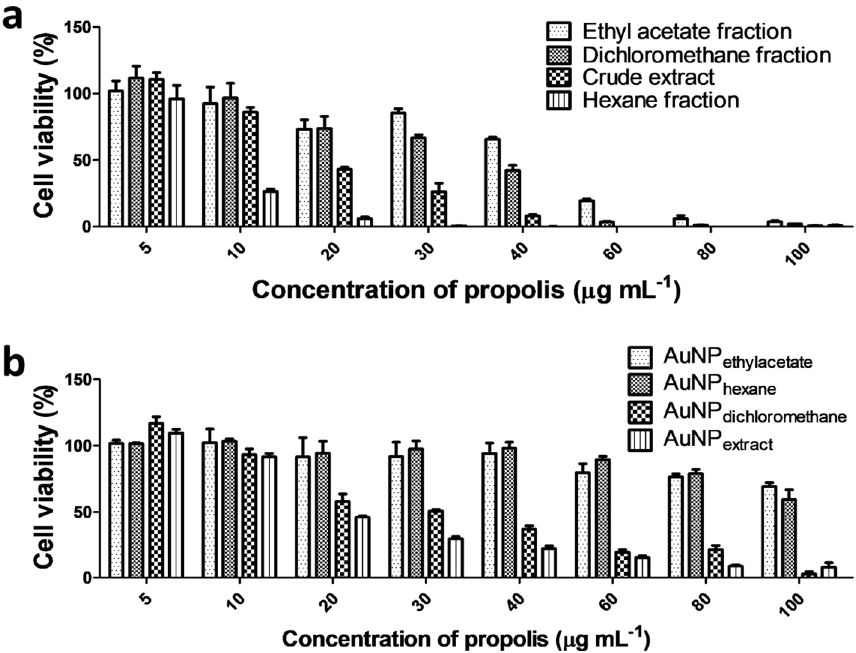
Figure 9. PC-3 cell viability of ( a ) biogenic nanoparticles ( b ) BRP crude extract and its fractions, obtained by ATP bioluminescence